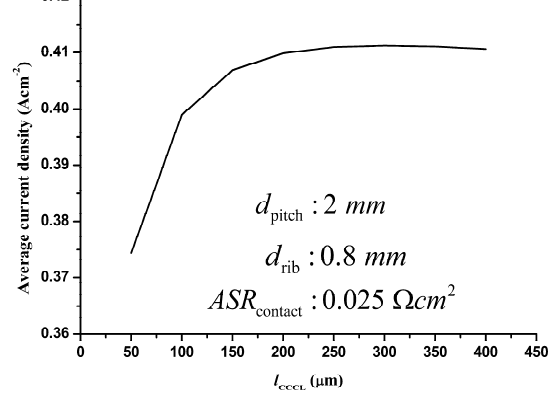
Figure 7. Variation of the average output current density with the CCCL layer